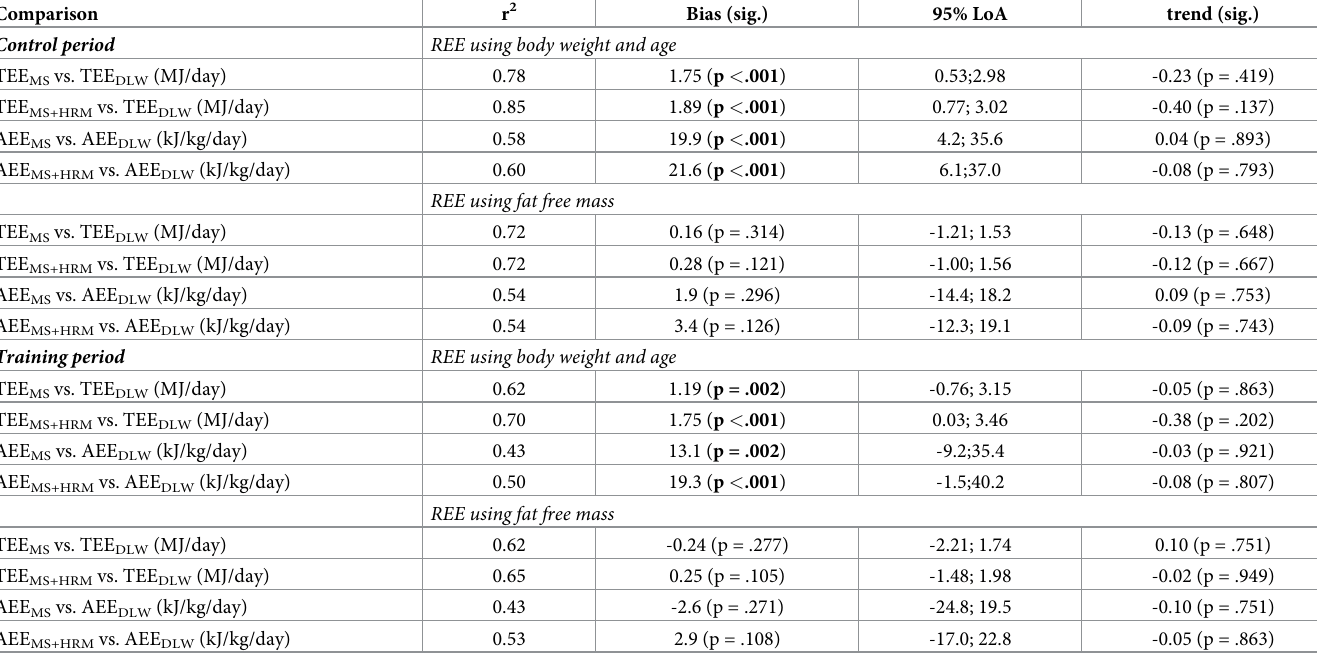
n = 15 during Control and n = 13 during Training period. LoA: Limits of Agreement in BA-plot; trend (sig.): slope and its significance in BA-plot indicating proportional bias between the methods. TEE: Total Energy Expenditure. AEE: Activity Induced Energy Expenditure. DLW: assessed by doubly-labeled water. MS: assessed by Motion Sensor (24/7); MS+HR: assessed by MS (24/7) and Heart Rate Monitor (during exercise